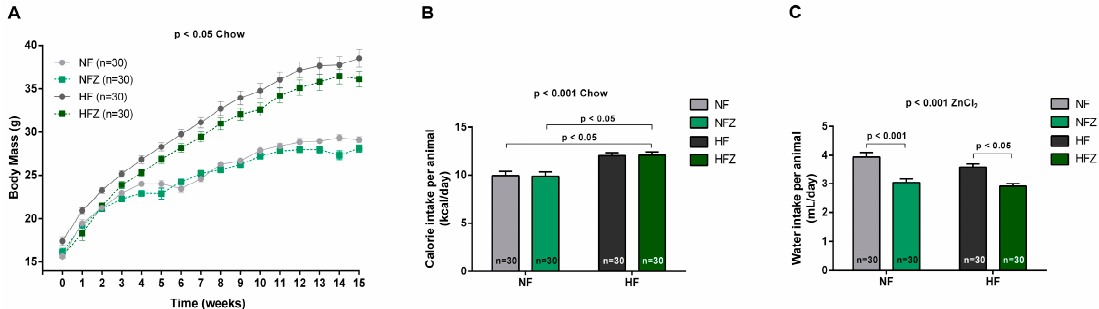
Figure 1. Body mass and caloric, hydric and ZnCl 2 intakes. Body weight gain ( A ), calorie intake ( B ) and water intake ( C ) of animals of the NF and HF groups and those supplemented with ZnCl 2 . Values are means ± S.E.M. Two-way ANOVA: final body mass (chow, p < 0.01; zinc, p > 0.05; interaction, p > 0.05); calorie intake (chow, p < 0.001; zinc, p > 0.05; interaction, p > 0.05); and, water intake (chow, p > 0.05; zinc, p < 0.001; interaction, p > 0.05).